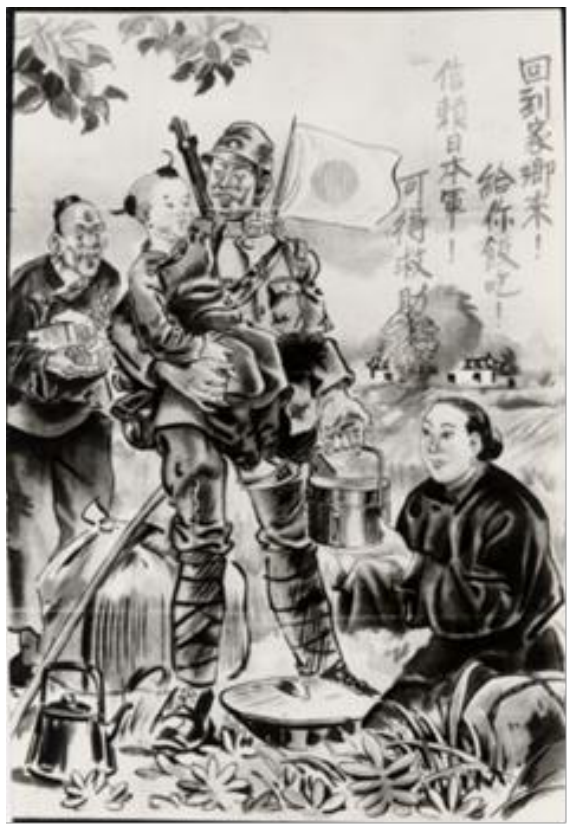
Figure 14. Japanese propaganda in China. Source: Un- known